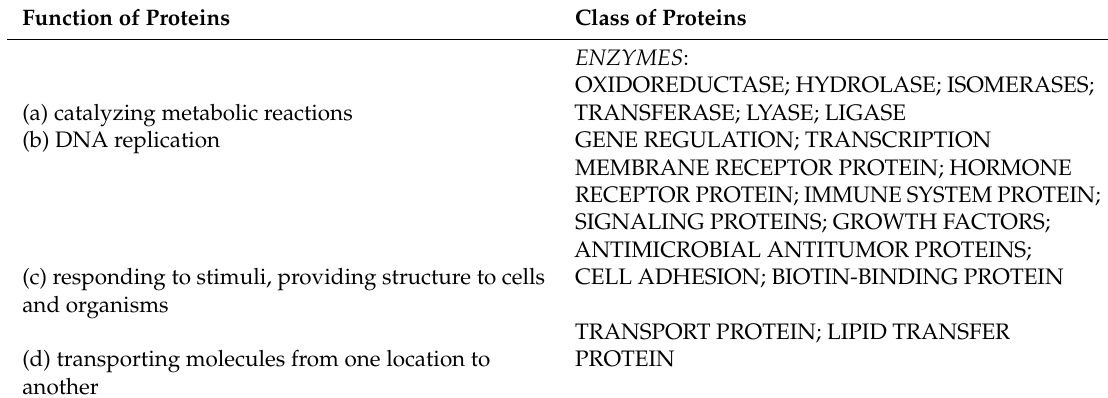
Table 1. A short description of groups of proteins investigated in this study related to di ff erent functions in